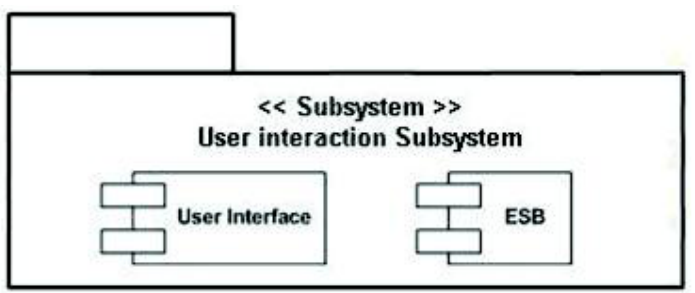
Figure 9. User Interaction subsystem and its inner components.